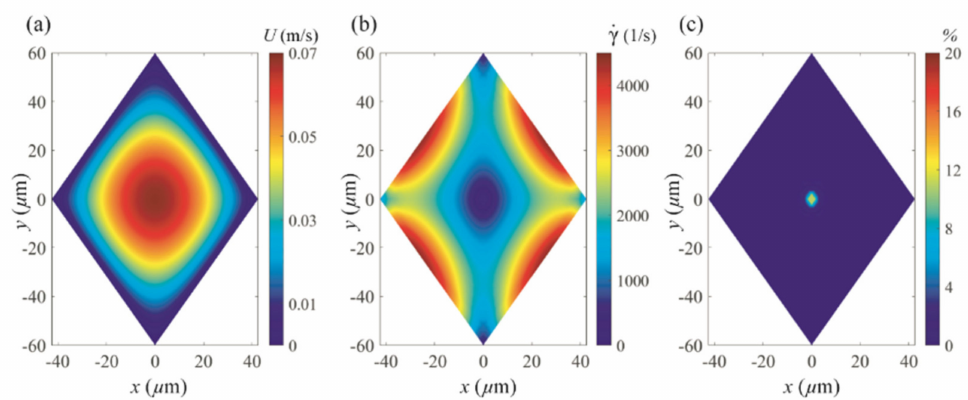
Figure 6. Simulation results of the ( a ) streamwise velocity magnitude (m / s), ( b ) shear rate (1 / s), and ( c ) percent discrepancy in the shear rate between the current viscoelastic fluid (PEO500 solution) and DI water in a cross section of the rhombic microchannel at 10 µ L /